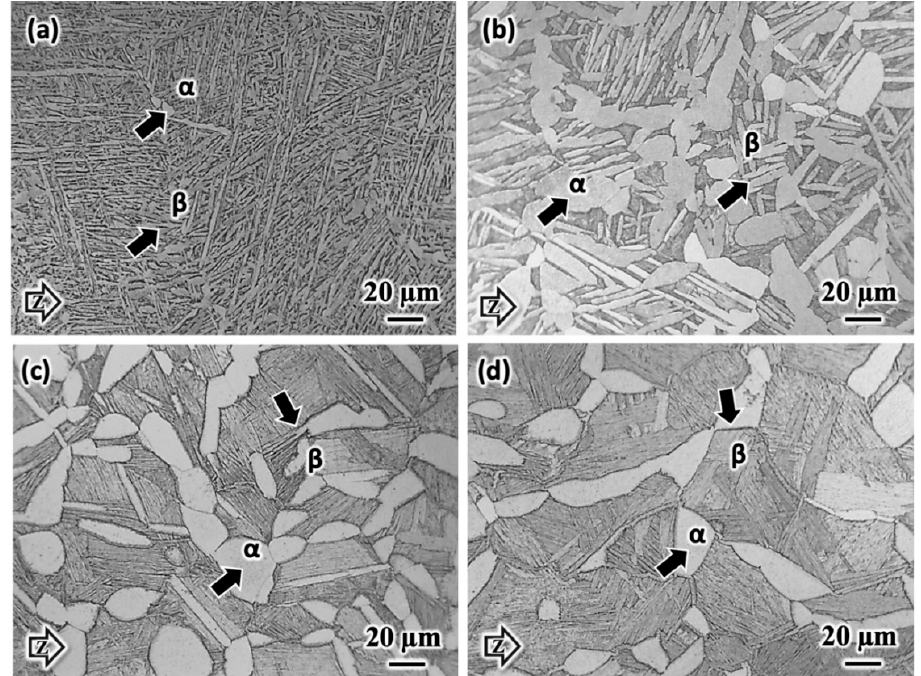
Figure 10. Optical micrographs of the HIP Ti-6Al-4V ELI alloy samples before and after heat treatment, followed by air cooling: ( a ) before heat treatment, ( b ) 920 °C for 200 h, ( c ) 950 °C for 200 h, and ( d ) 970 °C for 200 h. Table 6. Average lamellar width after heat treatment at 920, 950, and 970 °C as a function of time.